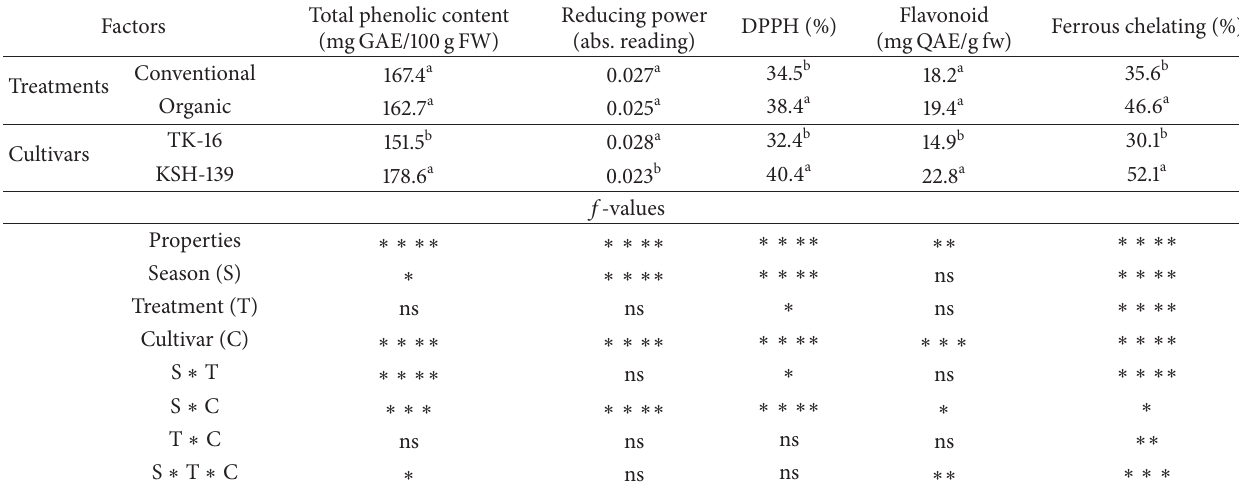
Values for each parameter followed by a different letter within each column are significantly different, 𝑃 ≤ 0 . 05 (Duncan’s Multiple Range Test). Abs. = absorbance at 700nm; GAE = Gallic Acid Equivalent; QAE = Quercetin Acid Equivalent; ns = values statistically nonsignificant ( 𝑃 > 0.05). ∗ = 𝑃 ≤ 0.05;